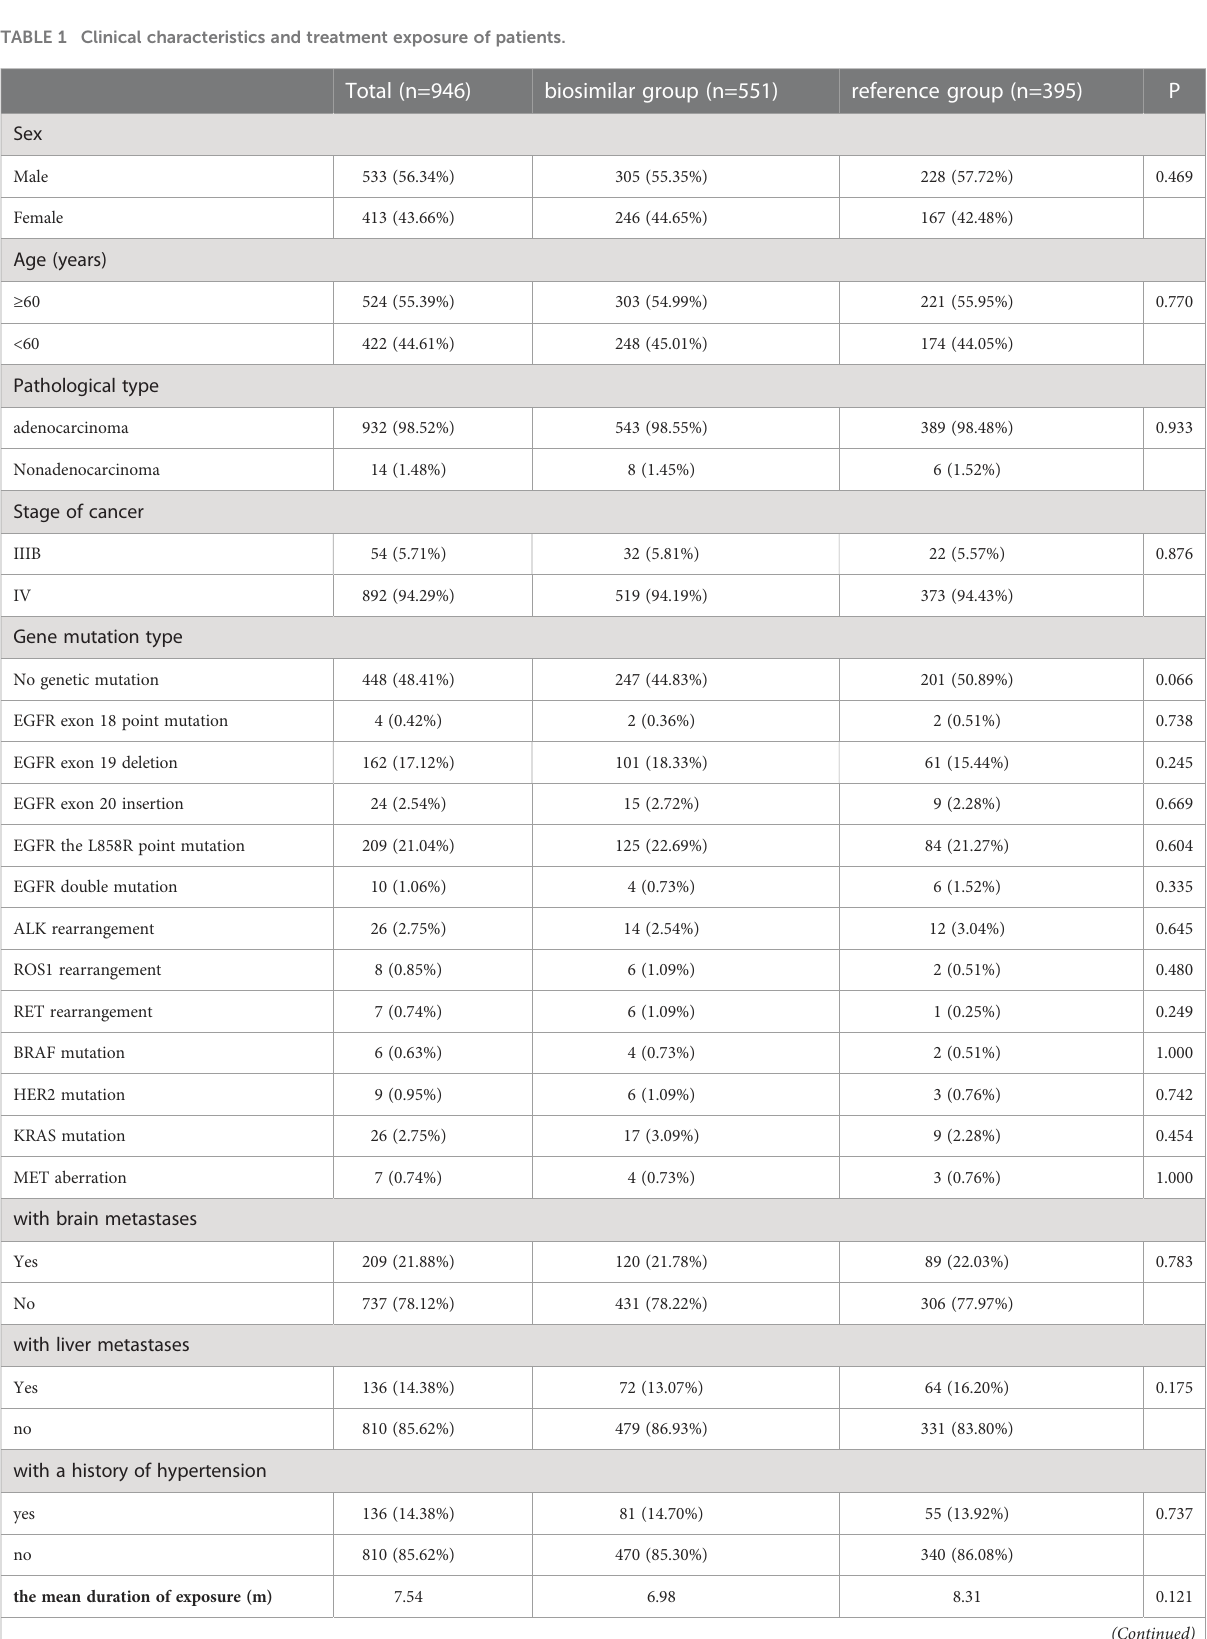
TABLE 1 Clinical characteristics and treatment exposure of